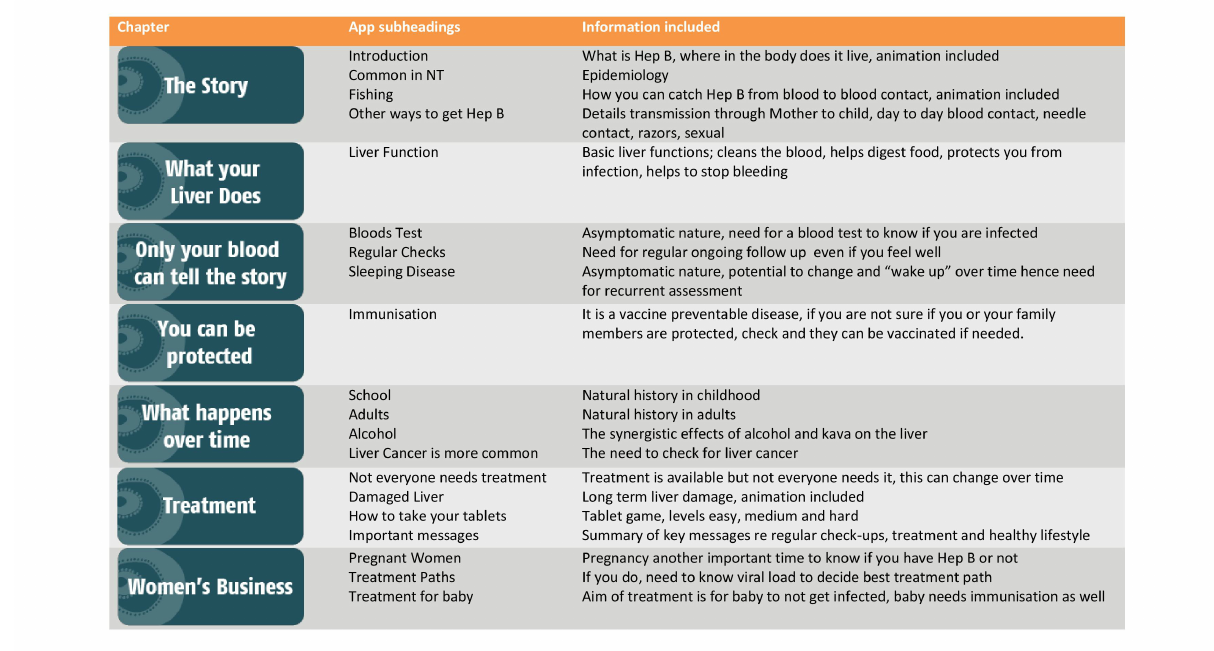
Figure 4. The contents of the Hep B Story